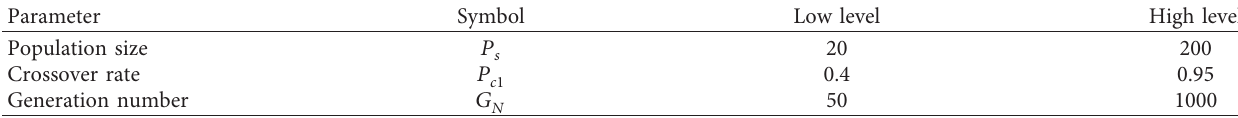
Table 11: Levels and values of the proposed GA parameters.